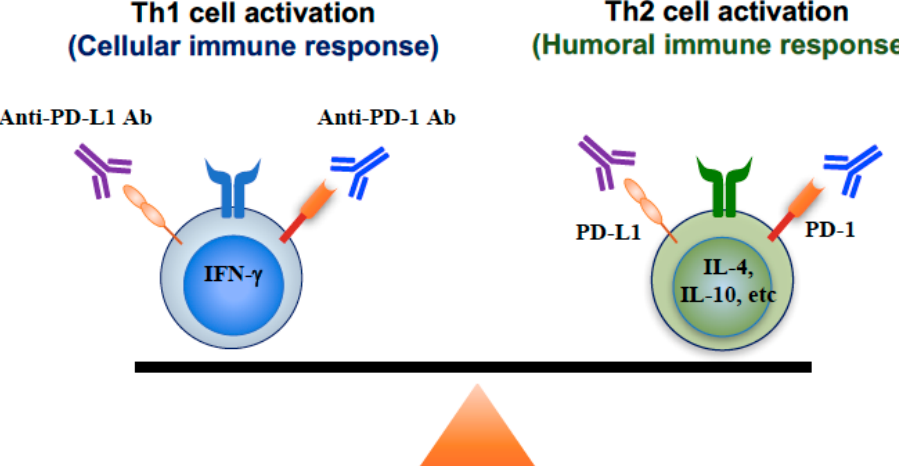
Figure 5. Underlying mechanisms of humoral immune response-associated irAEs. Panel ( A ) shows a model demonstrating the immune balance between a T cell-mediated immune response and a B cell-mediated immune response. Immune checkpoint inhibitors can activate both T cells (cellular immune response) and B cells (humoral immune response), and have the potential to modulate the balance between cellular immune response and humoral immune response, since PD-1/PD-L1 express on both T cells and B cells. Panel ( B ) shows a model demonstrating immune balance between the Th1 cell and the Th2 cell. Immune checkpoint inhibitors can activate both Th1 cells (cellular immune response) and Th2 cells (humoral immune response), and have the potential to modulate the balance between cellular immune response and humoral immune response, since PD-1/PD-L1 express on both Th1 cells and Th2 cells.